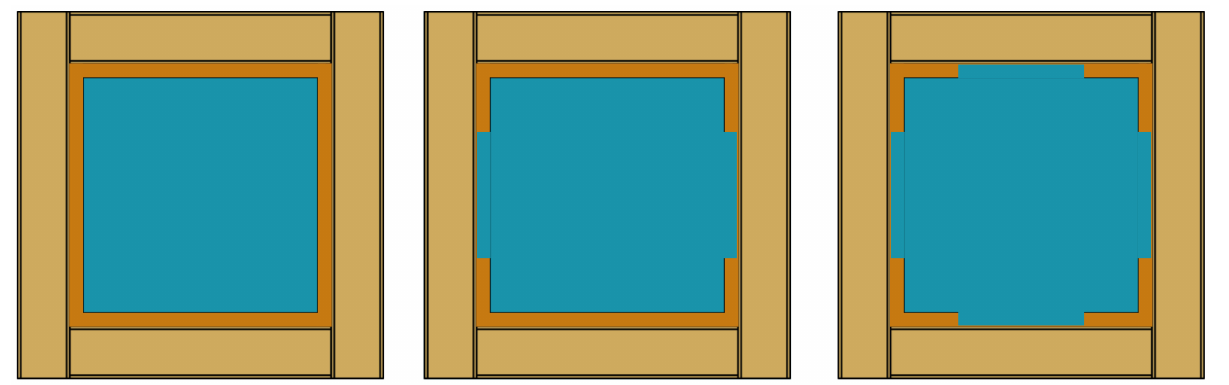
Figure 2. Steel plate shear wall with partial